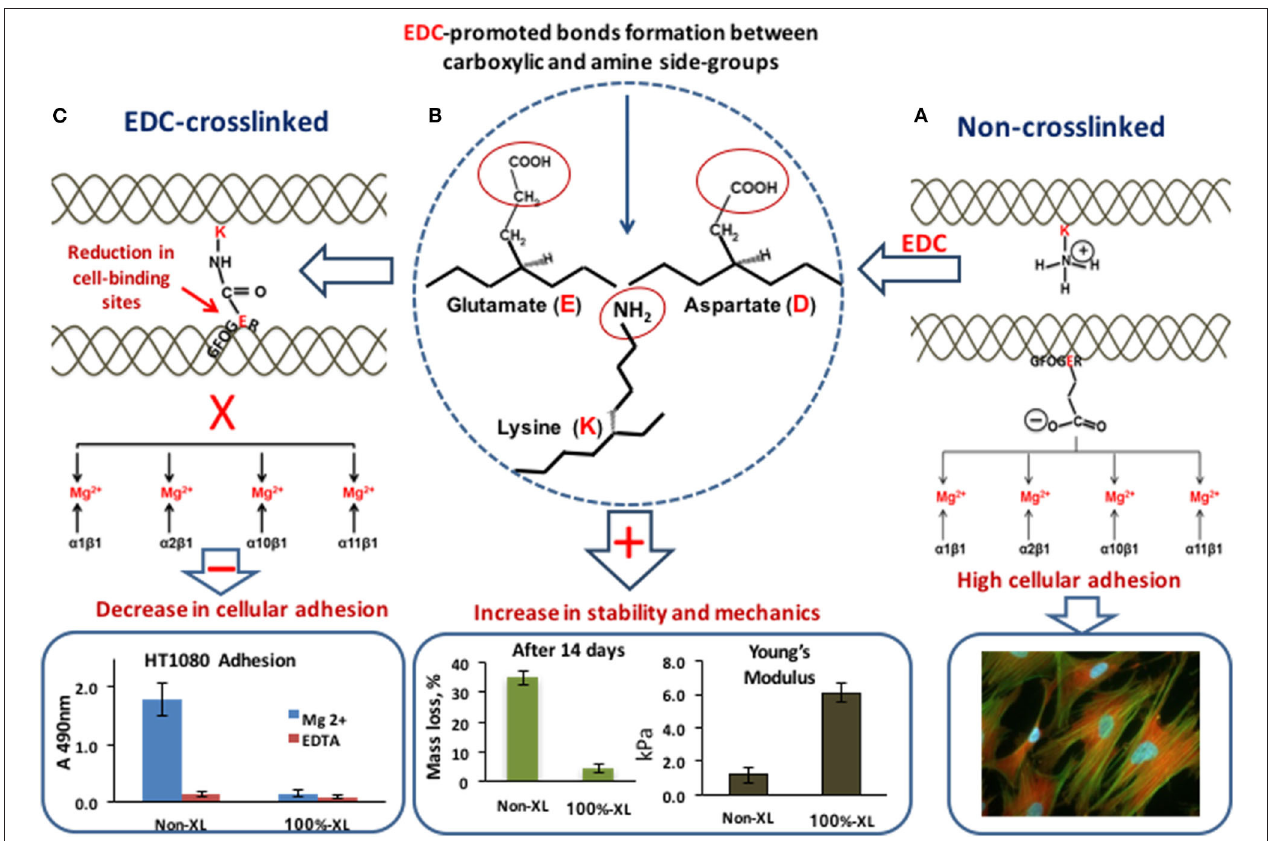
FIGURE 5 | EDC-crosslinking. (A) In non-XL collagen two adjacent collagen helices: with a lysine (K) amine-containing sidechain and with the integrin-binding motif GFOGER with its crucial glutamate acidic (E) side chain. The carboxylate anion is free to coordinate a Mg 2 + ion bound to the integrin α -subunit I domain, so that α 1 β 1, α 2 β 1, α 10 β 1, or α 11 β 1 can secure cell binding to the matrix. High cell adhesion. (B) EDC promotes the cross-linking of the glutamate (E) and aspartate (D) carboxylate group with the adjacent lysine (K) amine group. (C) Amide bond formation between adjacent collagen helices. The glutamate sidechain can no longer interact with integrins. EDC-crosslinking leads to the increase in scaffold stability to degradation and mechanical properties but affects the number of cell-binding sites with a negative effect on cell attachment. Data for graphs in the figure were replotted from Davidenko et al. ( 72) and Davidenko et al.